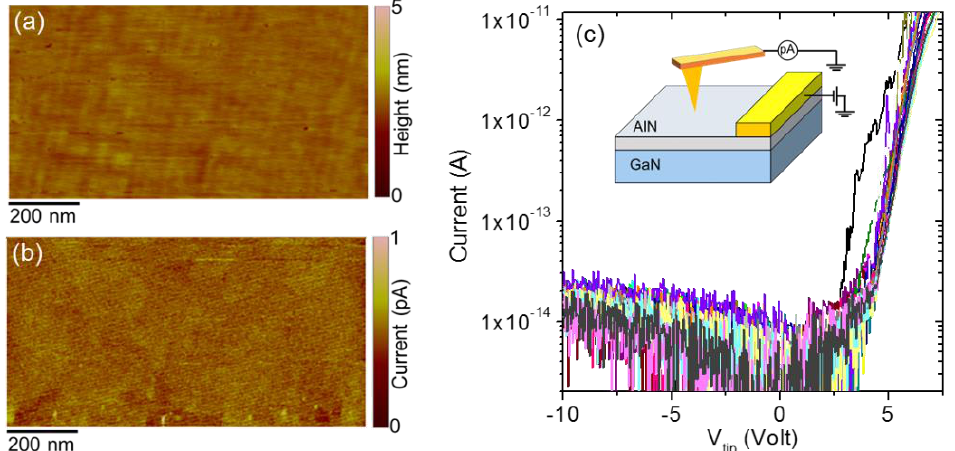
Figure 5. ( a ) Morphology and ( b ) vertical current map on 5 nm AlN film on GaN measured by C-AFM at a tip bias V tip = 5 V. ( c ) Local I–V curves measured on an array of 5 × 5 positions of the diamond-tip on the AlN surface. The experimental configuration for C-AFM measurements is schematically illustrated in the insert of panel ( c